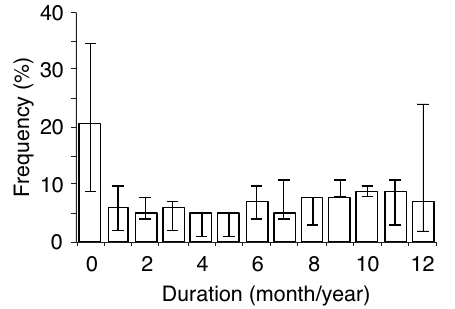
Figure 7. Frequency distribution of drought duration per an- num (i.e. consecutive month with F A < 0km 2 ), with error bars representing the variation in the distribution when threshold for drought duration is defined as F A < ± 56km 2 for the last century ( n = 100 years).